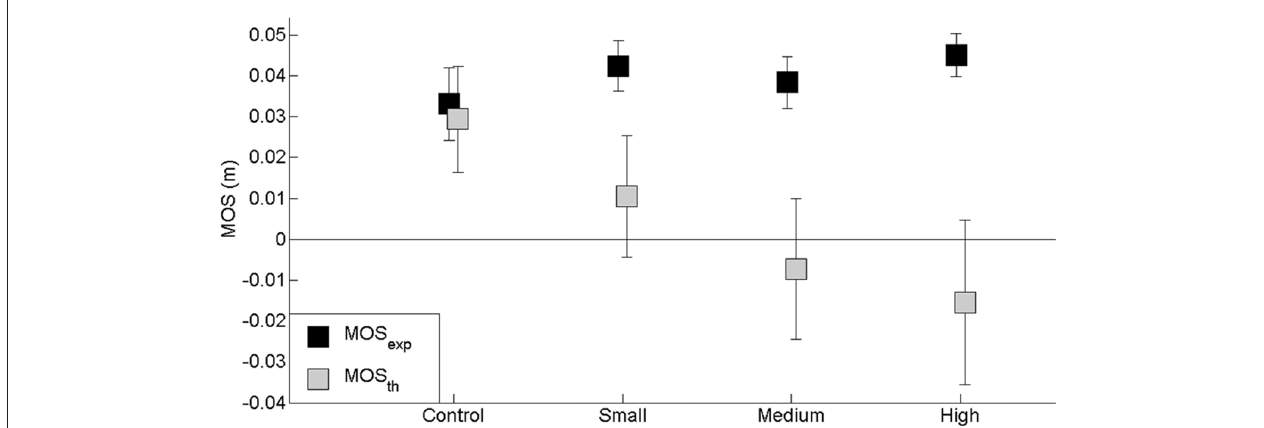
FIGURE 7 | Effects of obstacle height on the experimental (MOS exp ) and theoretical (MOS th ) “margin of stability” (MOS) values computed in the conditions with no APA scaling. The height of the obstacle is indicated in the abscissa (small, medium and high). In the control condition, there was no obstacle. Reported are mean values (all participants together) ± 1 SD. Note that the experimental MOS values remained unchanged, while theoretical MOS values decreased with obstacle